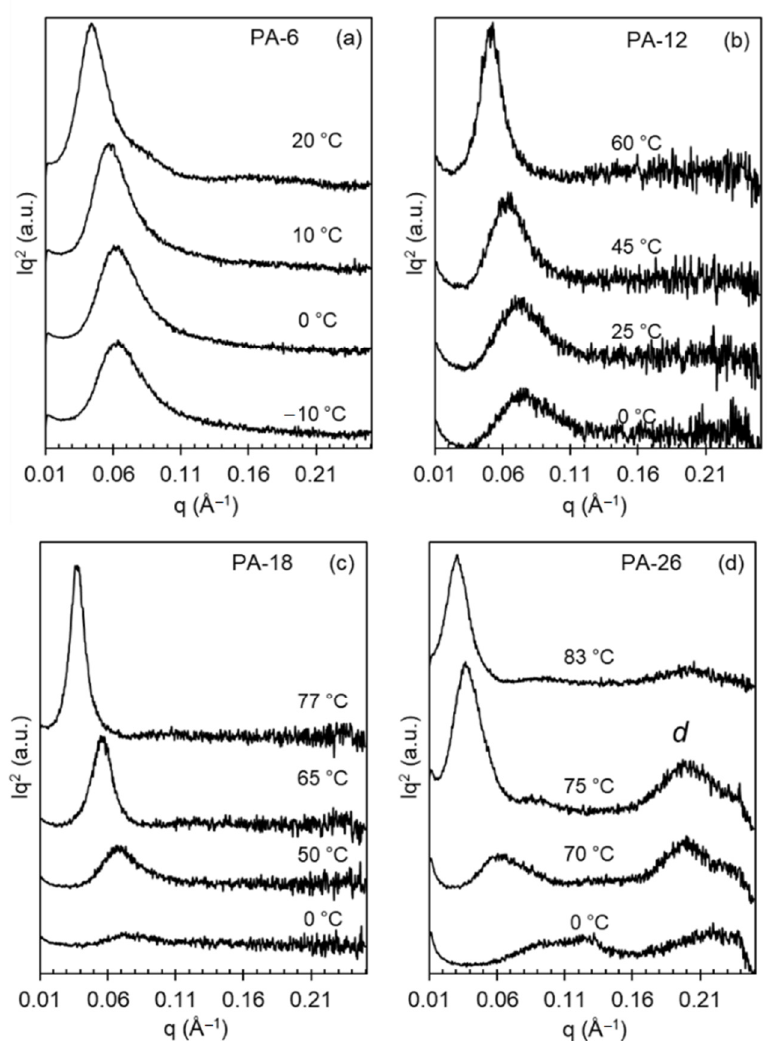
Figure 10. Lorentz-corrected small-angle X-ray scattering patterns for ( a ) PA-6, ( b ) PA-12, ( c ) PA-18, and ( d ) PA-26 collected on heating to the indicated temperatures. d denotes the crystalline acetal layer peak. Data have been vertically shifted for clarity.